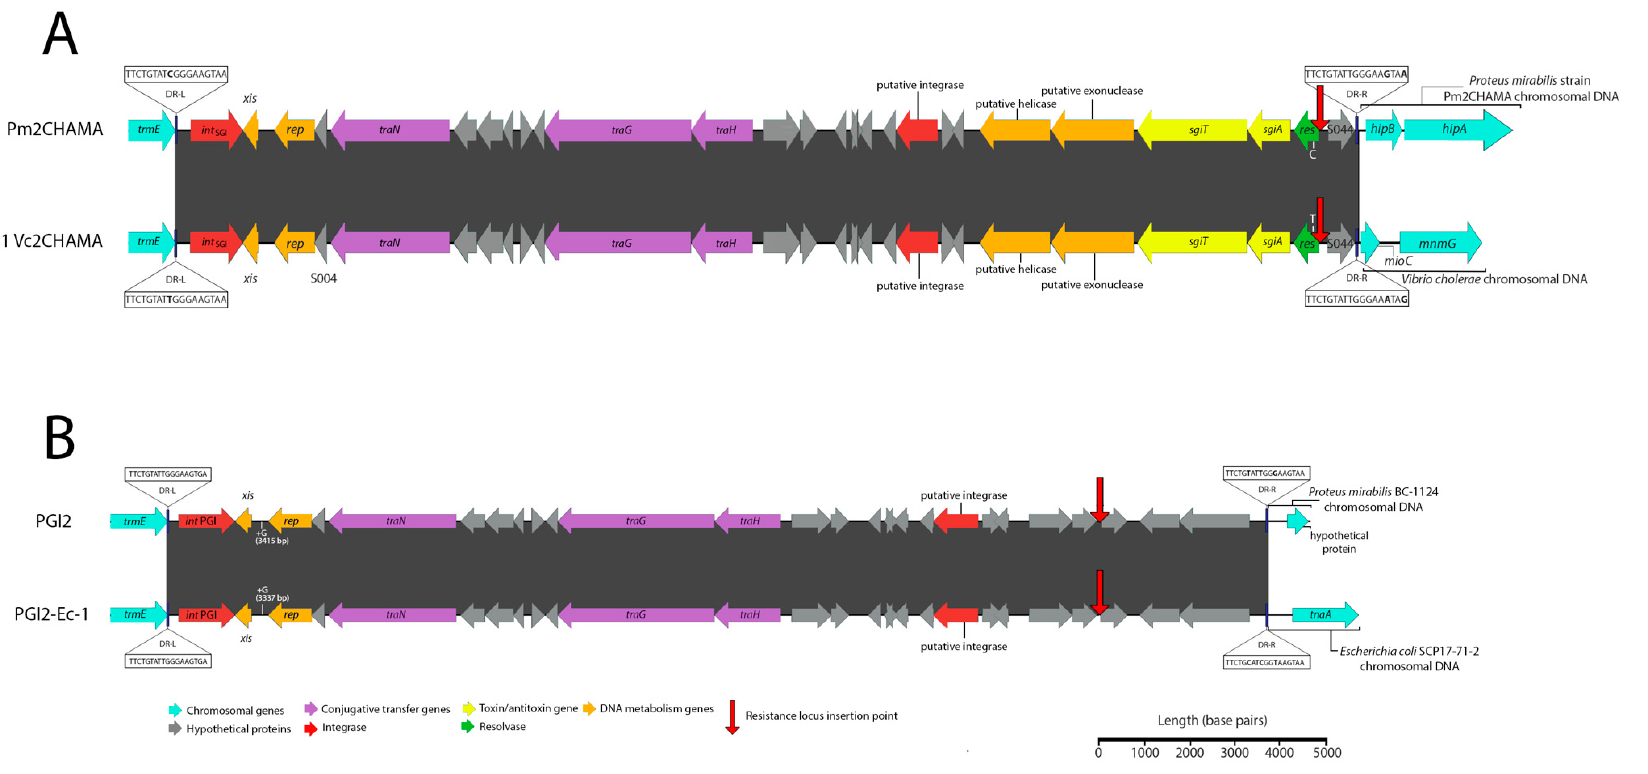
Figure 3. Schematic depicting SGI1-REs identified in this investigation. Scale is approximate. Closely related SGI1-REs from public databases are shown to allow visualization of the nucleotide identity across the novel elements and the associated references. Identities and locations of single nucleotide polymorphisms are indicated atop vertical lines at the top and bottom of either element, while nucleotide insertions are indicated in the same fashion but denoted with a plus symbol ( + ). Nucleotide identities of trmE genes (not shown) did not exceed greater than 75% for SGI1 Pm2CHAMA or PGI2-Ec-1 in comparison with the trmE genes of other sequences represented in this schematic. ( A ) A comparison of SGI1 Pm2CHAMA (Accession No: MF372716) shown atop SGI1 Vc2CHAMA (Accession No.